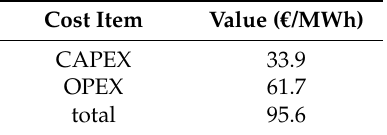
Table A9. LCOHC of the reference